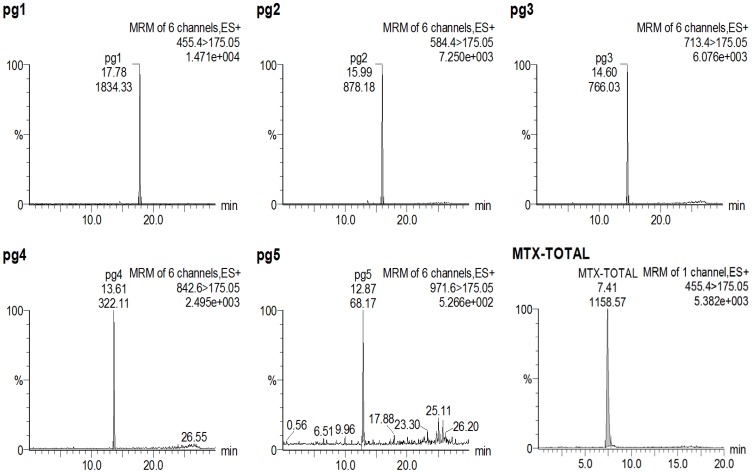
Representative chromatograms of an extracted DBS sample obtained from JIA patient treated with MTX; (pg1–5): MRM chromatograms of individual MTXPGs; concentrations found were MTXPG1, 9 nmol/L; MTXPG2, 10 nmol/L; MTXP3, 15 nmol/L; MTXPG4, 10 nmol/L and MTXPG5, 7 nmol/L, respectively.(MTX-total): Chromatogram after conversion of total MTXPGs to MTXPG1; total concentration found was 49 nmol/L.